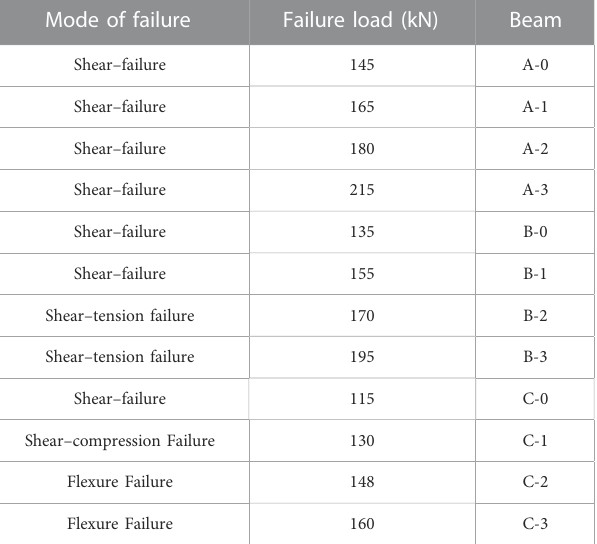
TABLE 10 Summary of failure loads and mode of failure for all tested beams.